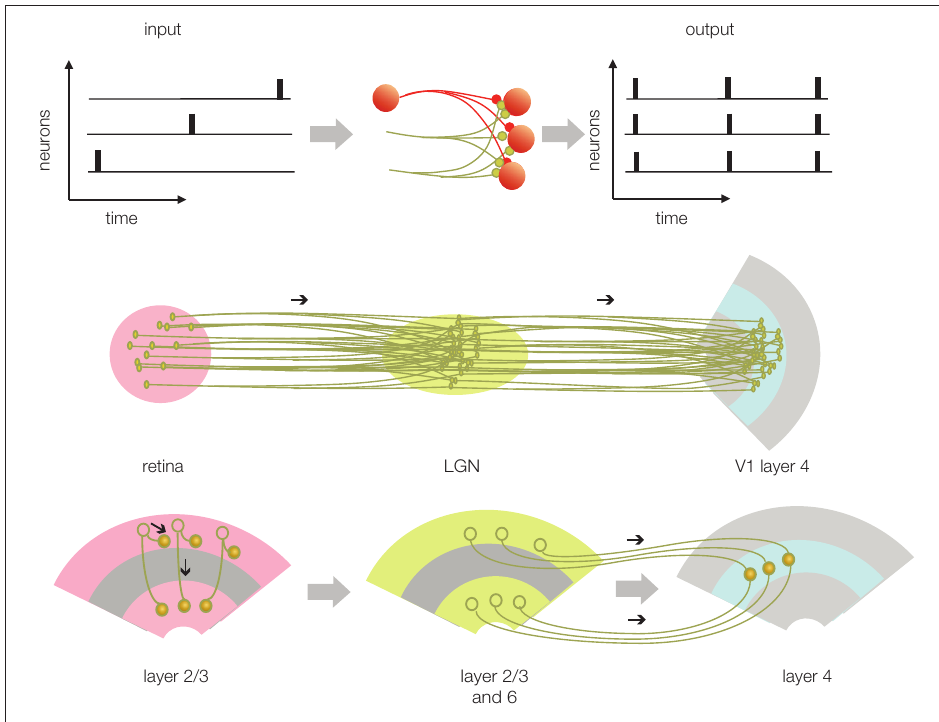
Figure 4 | Transferring the phase code (from Figure 3) between structures. The upper left is the phase-encoded AP pattern from Figure 3C . In this code AP time represents the luminance of the image in the receptive field and the position of neuron represents geometry. When the phase code enters a structure that relays the information (middle), the divergent and convergent connections will cause the APs to be dispersed and projected on a set of output neurons. As a result of the dispersion, all of the APs from each connected neurons will be combined with all other APs. The output AP trains will represent the combined APs from all the neurons. On the one hand, this code is compressed at the cellular level because it contains all the APs from all the neurons. On the other hand, the code is redundant across neurons. Underneath, middle row is the potential correspondence with the retina, LGN, and V1. Bottom, potential correspondence of the compression and transfer scheme with the cortico-cortical information